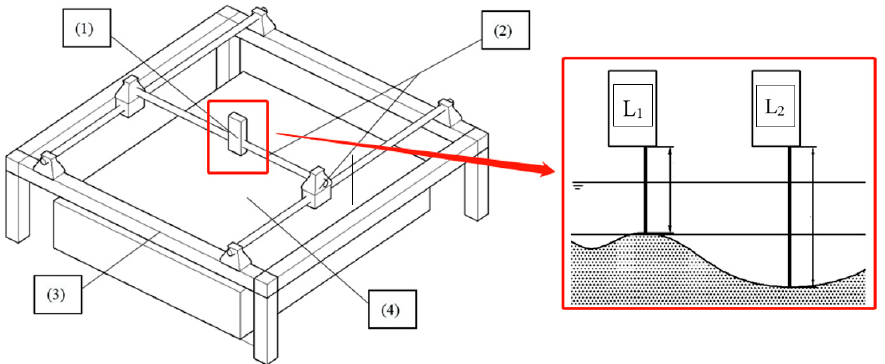
Figure 3. Measurement system. (1) Laser rangefinder; (2) Optical axis and sliding block; (3) Support (1 m × 1 m × 0.5 m); and, (4) Experimental tank.